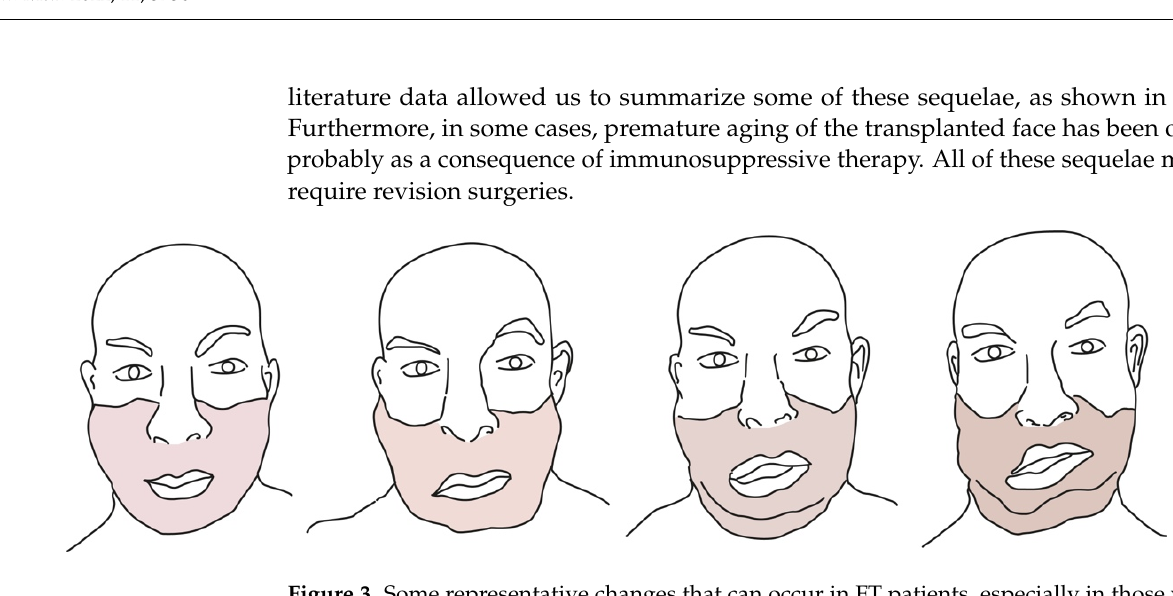
Figure 3. Some representative changes that can occur in FT patients, especially in those who have faced multiple acute rejection episodes. We noted, especially in patients who faced multiple acute rejection episodes, a lymphedematous aspect, sagging, asymmetry, loss of laxity, and pigmentation changes in the transplanted area.